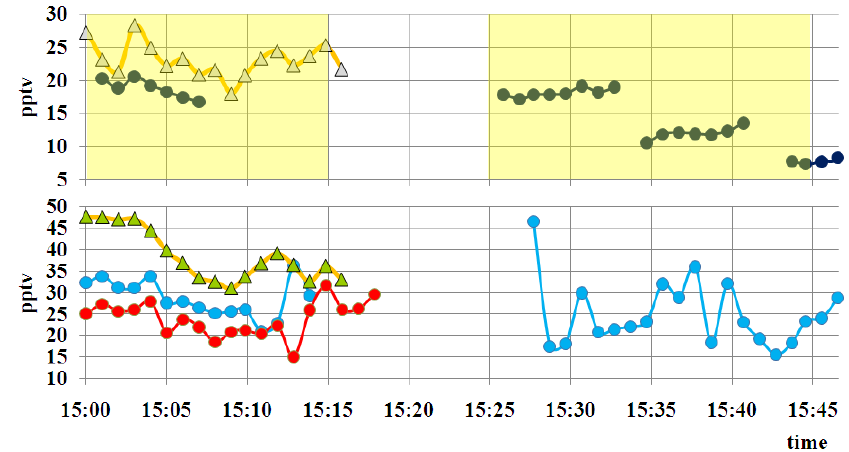
Figure 10: Comparison of model and observations ([HO 2 ] in dark blue, [RO 2* -D-Falcon] in blue and [RO 2* -BAe-146] in red) for the 697 hPa pressure level during the intercomparison exercise. Model results (triangles) are constrained to j (NO 2 ) and j (O 1 D) measured on board the BAe-146. The periods of the intercomparison are highlighted in the top figure in yelow.